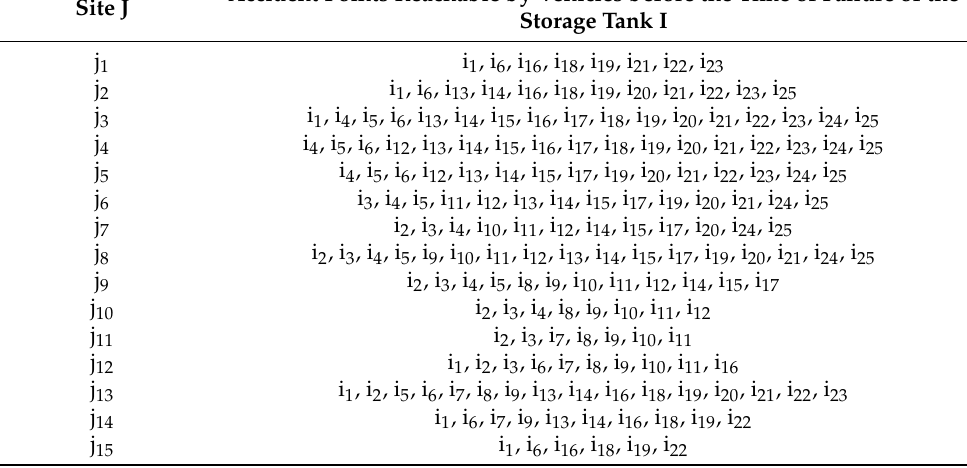
Table 4. Accident points reachable by